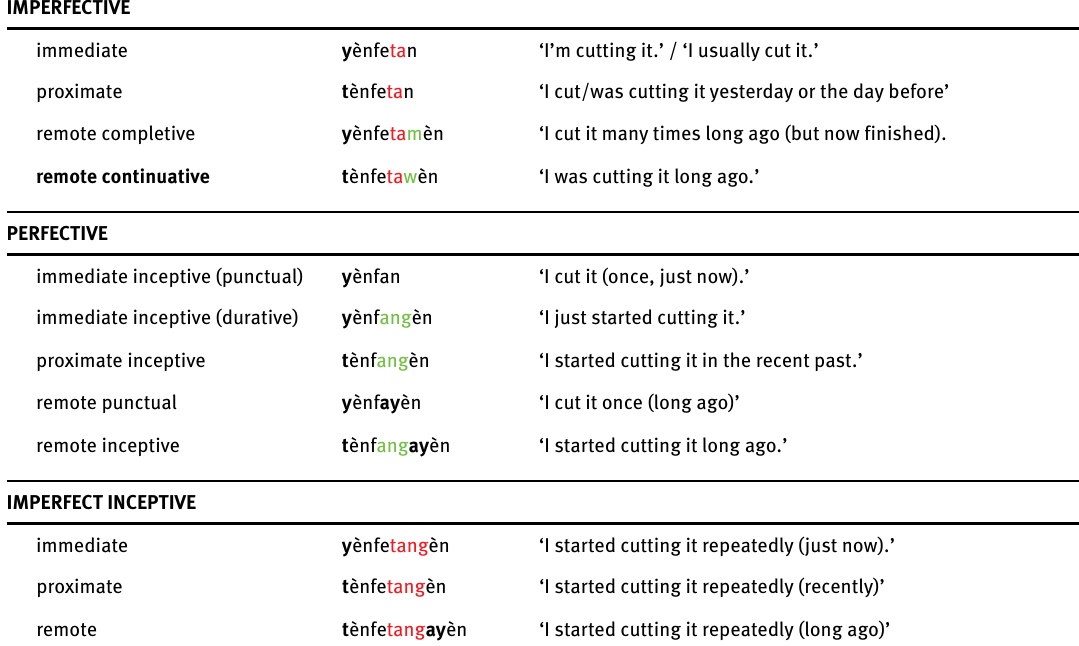
Table 14: Various tense/aspect forms of the verb *nèfè ‘cut’